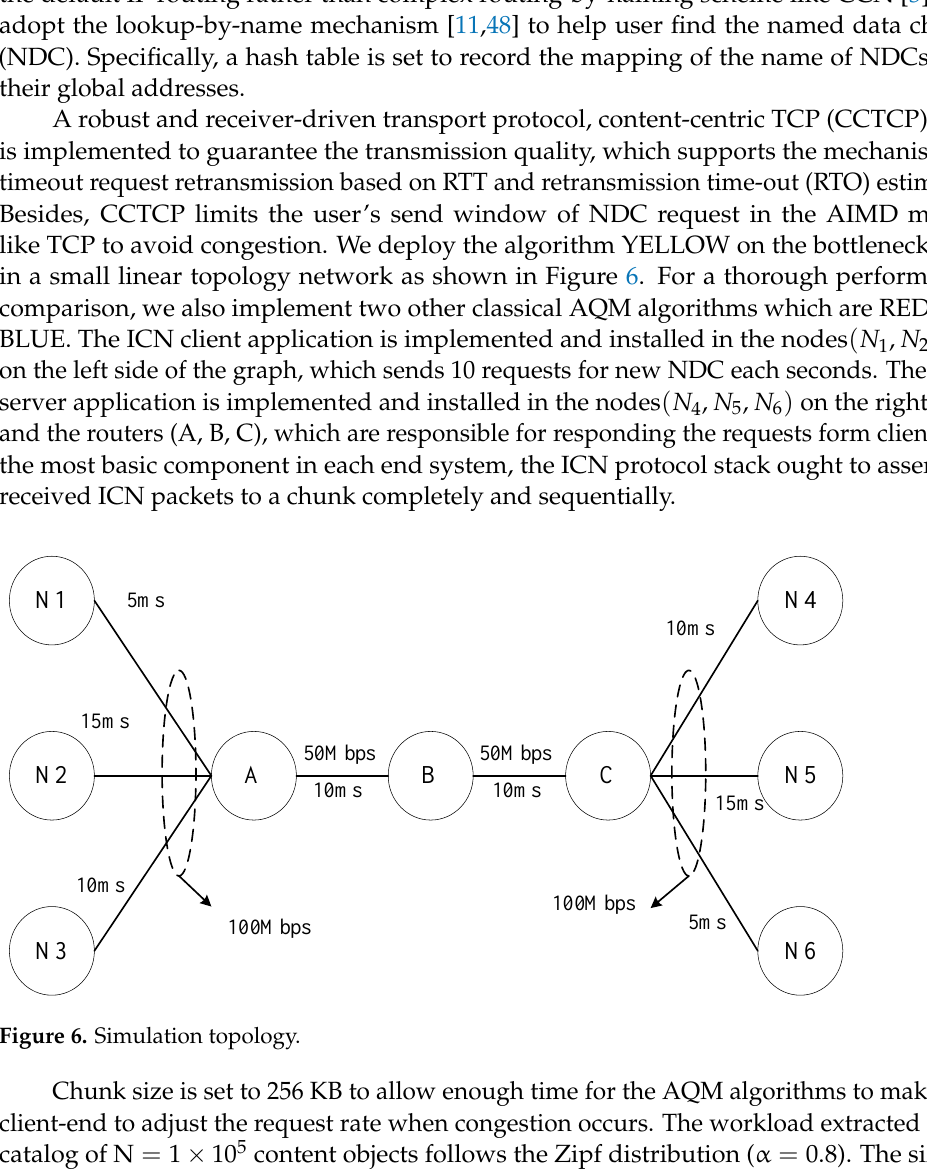
Table 3. RED configuration.